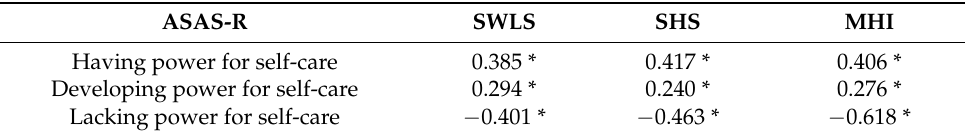
Table 4. Convergent validity (Pearson’s